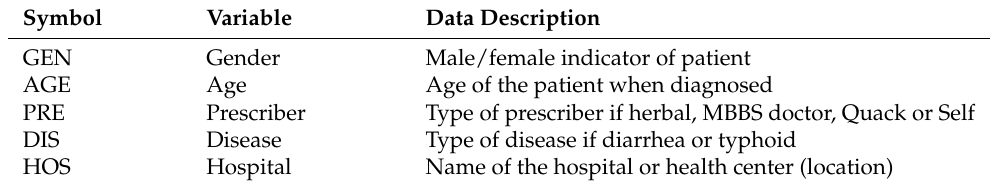
Table 1. Data variables on patient’s general